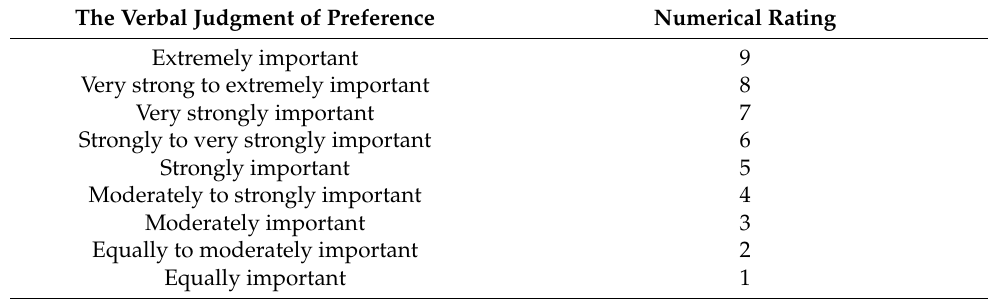
Table 1. AHP table of relative score [32].